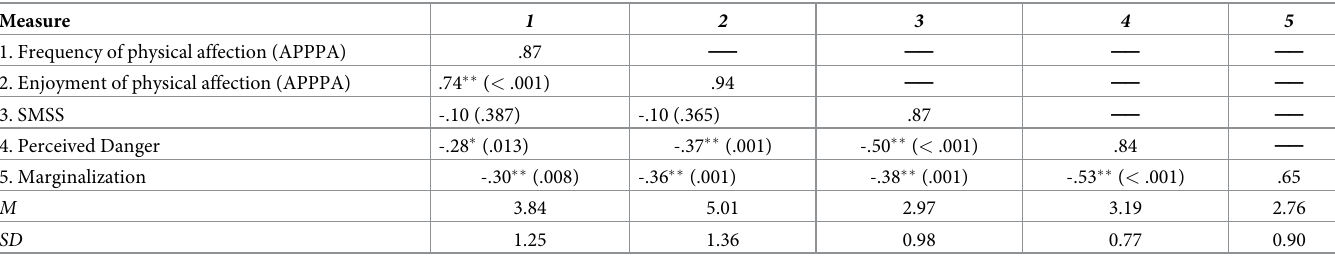
Table 4. Summary of correlations, reliabilities, means, and standard deviations for the physical affection and minority stress scales in Study 3.